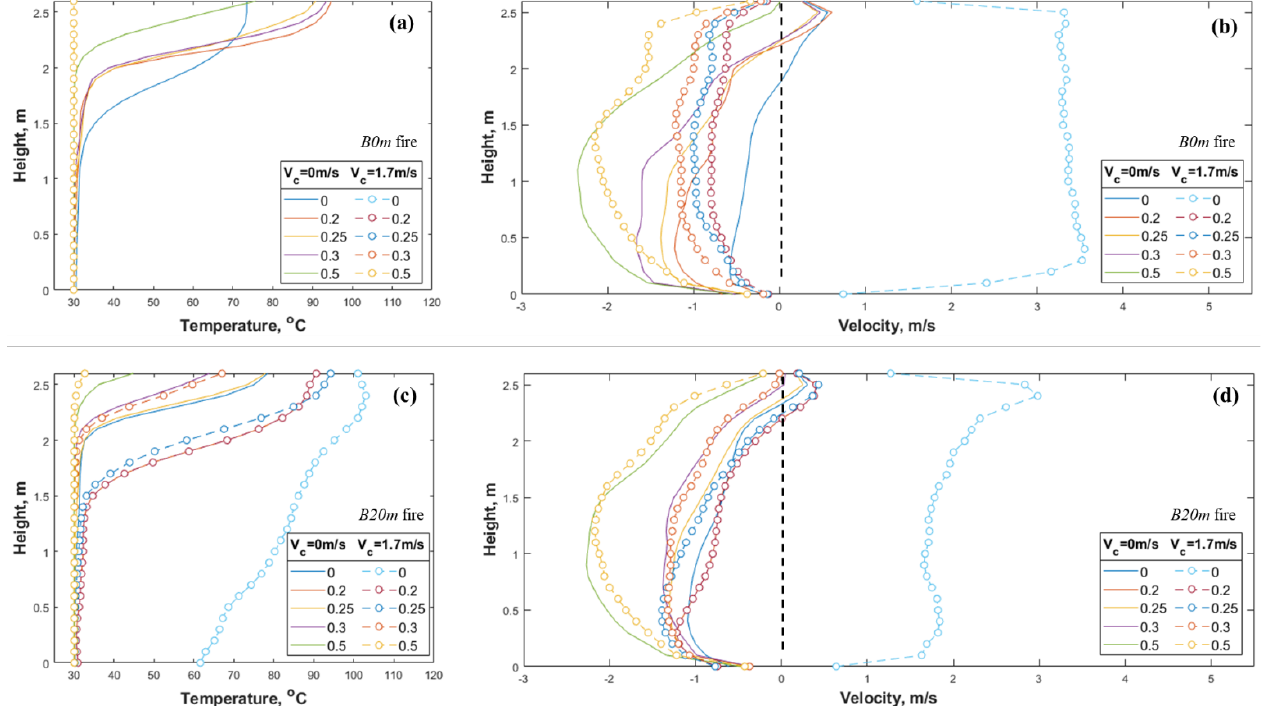
Figure 11. ( a , c ) Temperature and ( b , d ) doorway velocity distribution along the centre of the first cross-passage doorway of the undercarriage fires cases ( B0m and B20m ) for different tunnel and cross-passage